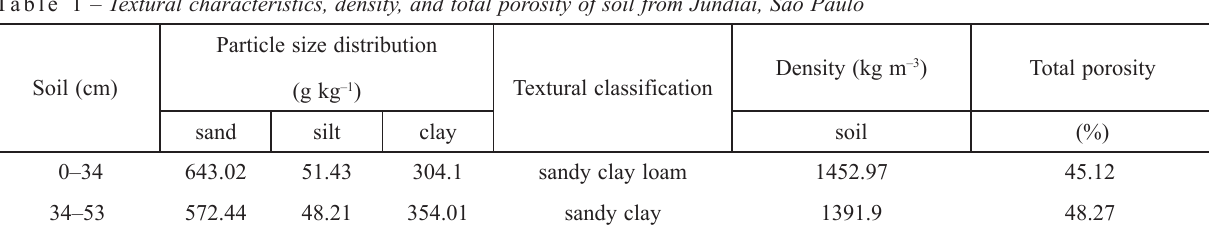
Table 1 – Textural characteristics, density, and total porosity of soil from Jundiaí, São Paulo